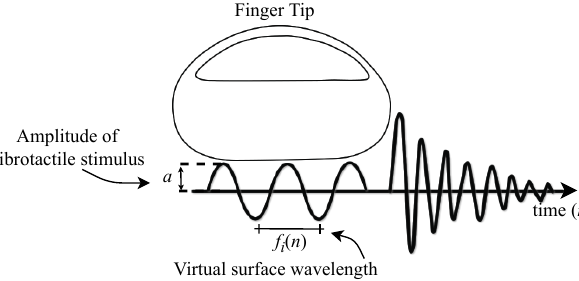
Figure 3. The vibrotactile stimulus for